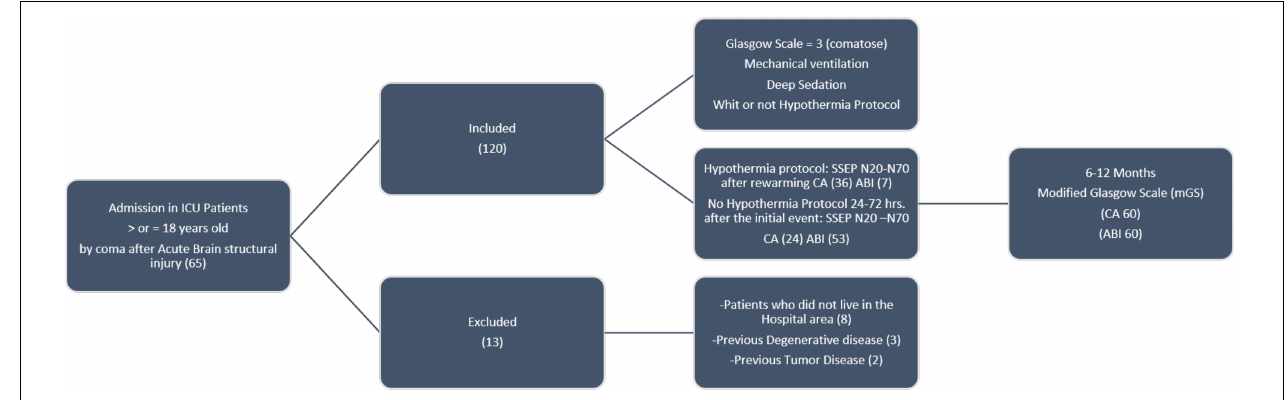
FIGURE 1 | Methodology inclusion, exclusion of patients, and procedures.